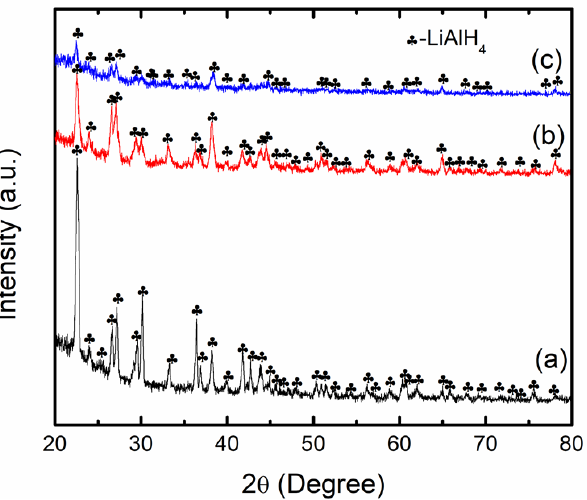
Figure 8. The XRD profile of ( a ) commercial LiAlH 4 , ( b ) as-milled LiAlH 4 and ( c ) LiAlH 4 + 10 wt.% CoTiO 3 .